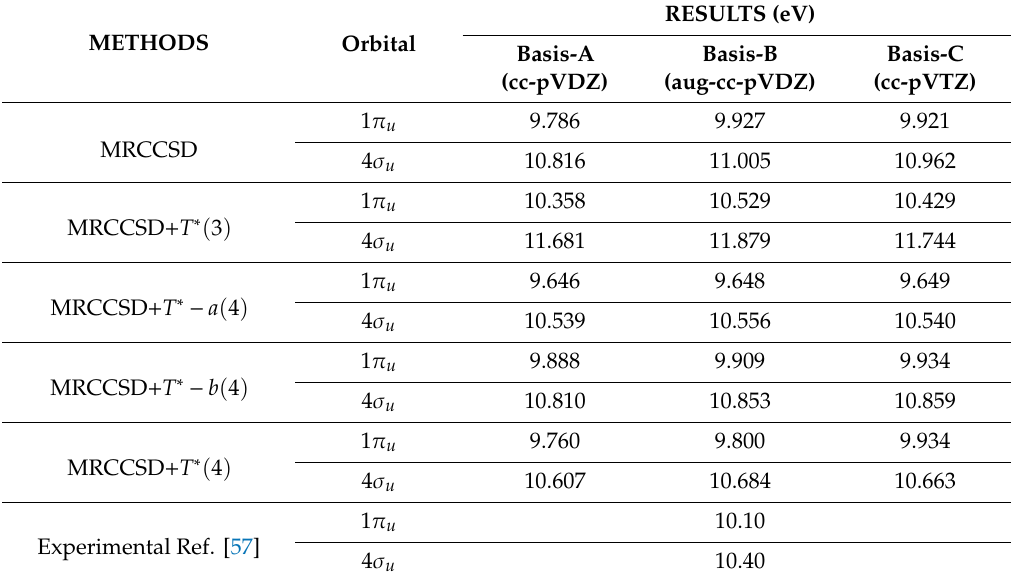
Table 3. Vertical IPs of BeO using various basis sets.